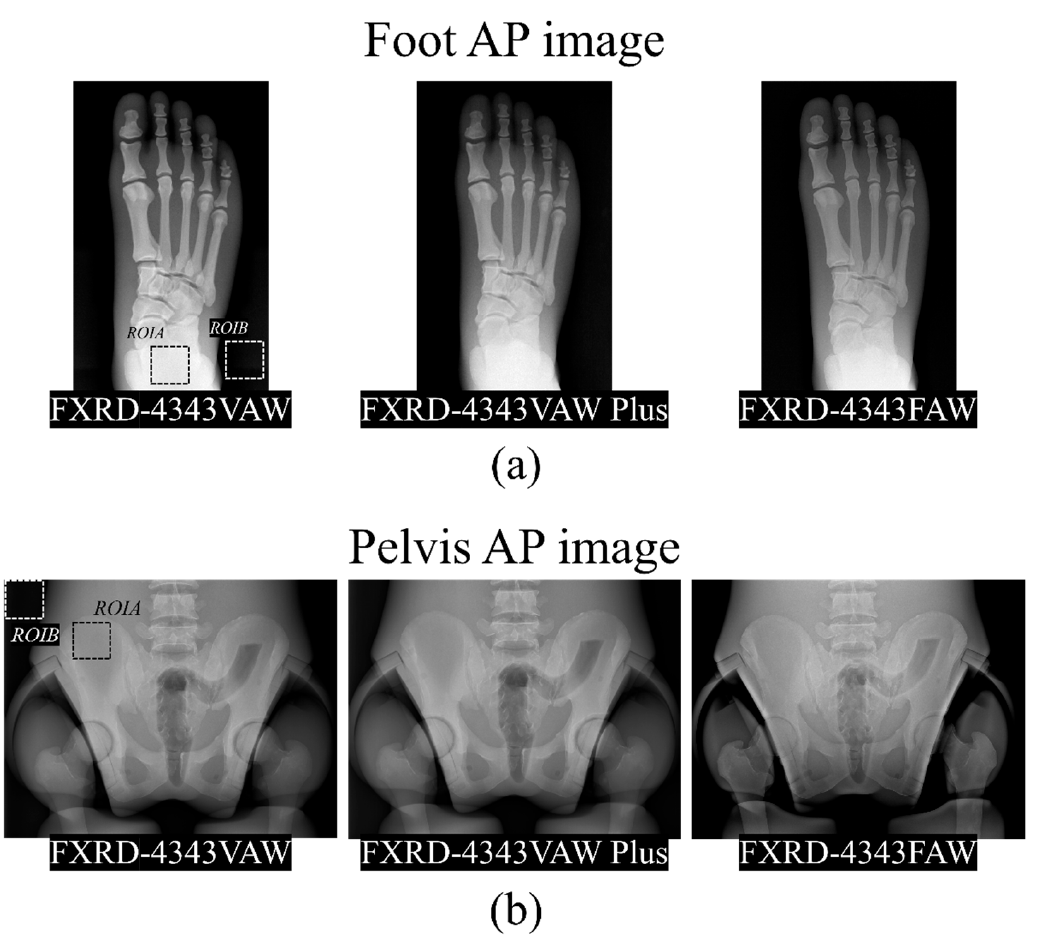
Figure 3. Example of ( a ) foot AP and ( b ) pelvis AP radiographic images obtained using the FXRD- 4343VAW ( left ), FXRD-4343VAW Plus ( middle ), and FXRD-4343FAW ( right ) detectors.